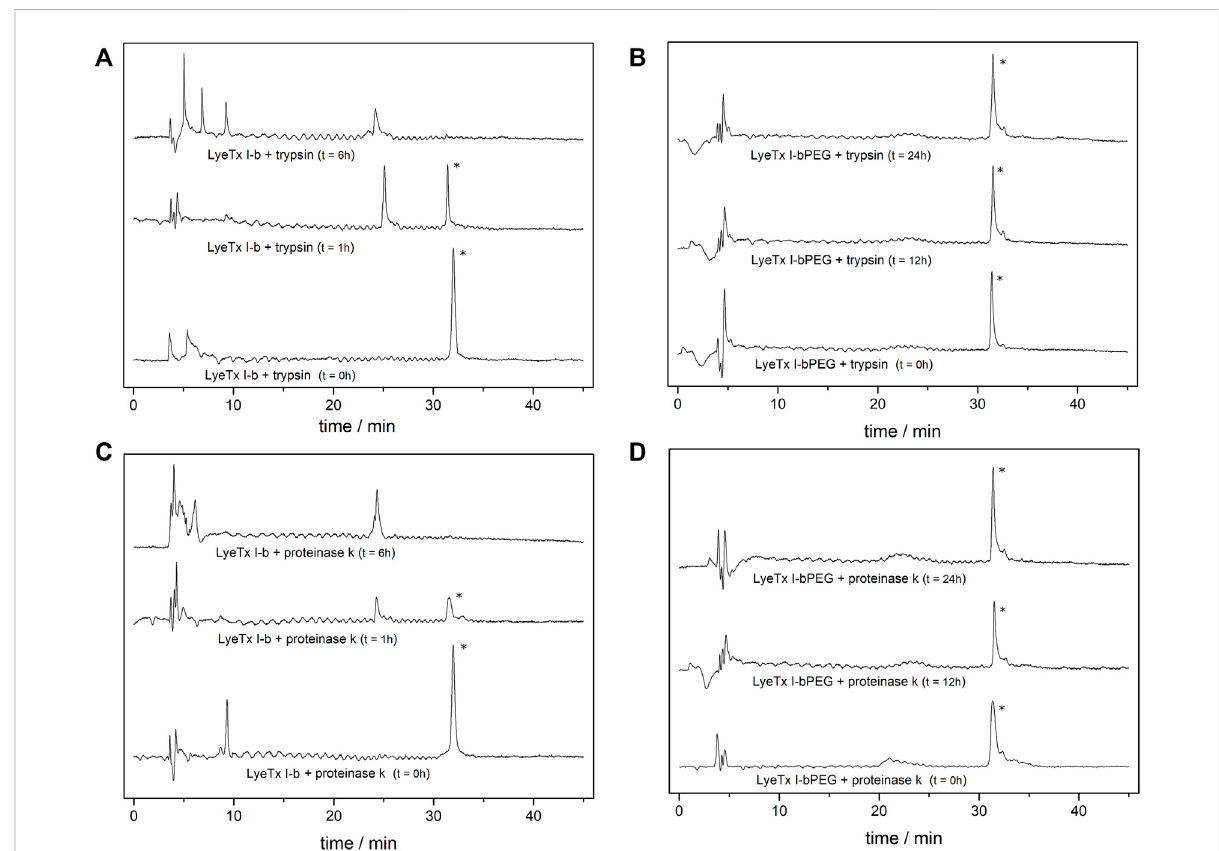
Comparative proteolytic degradation of LyeTx I-b and LyeTx I-bPEG. Peptides at 50 mM concentrations were incubated for 24 h with 1:50 (enzyme to substrate) weight ratio of (A) trypsin, (C) proteinase K, and 1:25(enzyme tosubstrate)weightratioof (B) trypsin and (D) proteinaseK, all in 10 mM potassium phosphate, pH 8.0, at 37 °